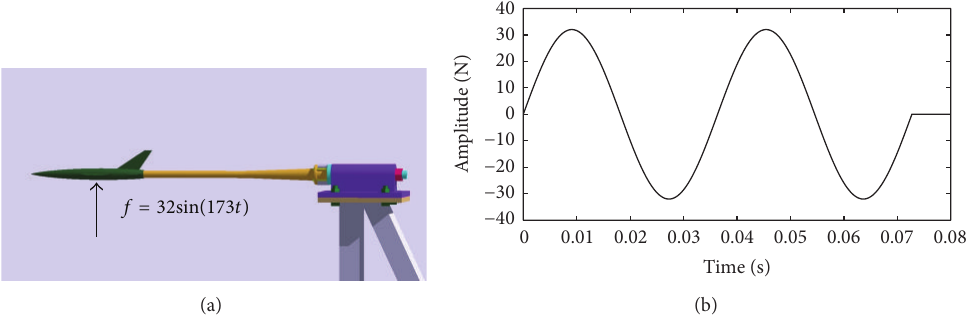
Figure 7: (a) and (b) show diagram of the sting system and a sine wave force, respectively.